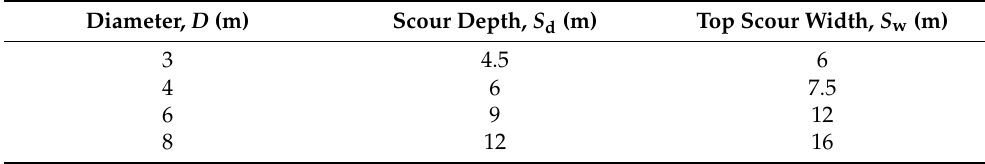
Table 4. Parameters of scour holes.